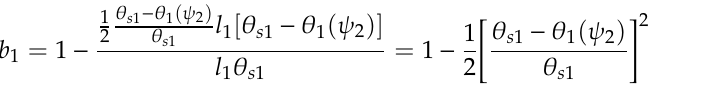
Figure 7. The distribution of soil water content along the soil profile when the buried depth of sand is